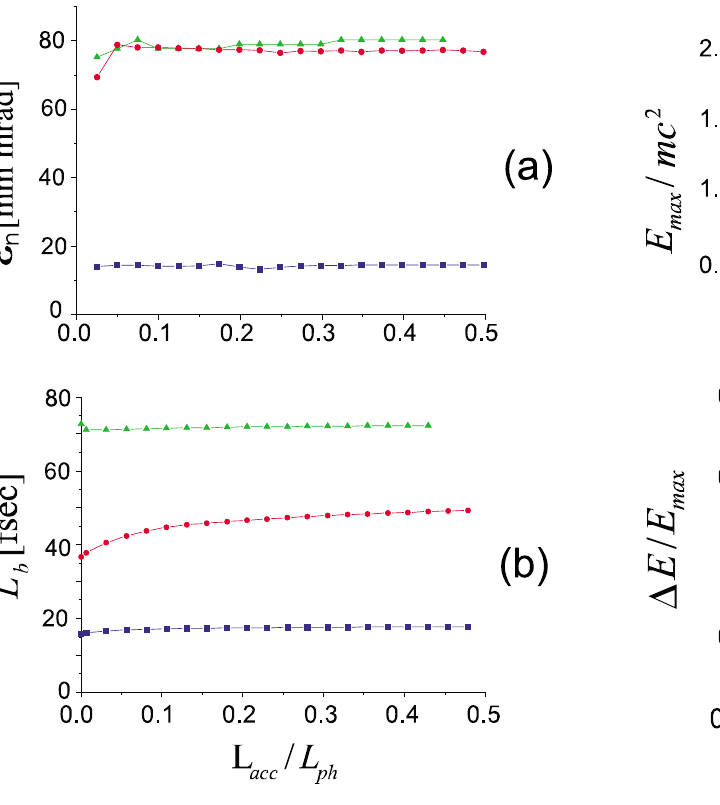
FIG. 7. (Color) Dynamics of the normalized emittance and bunch duration in the accelerator stage. All the parameters are similar to those given in the caption of Fig. 5.